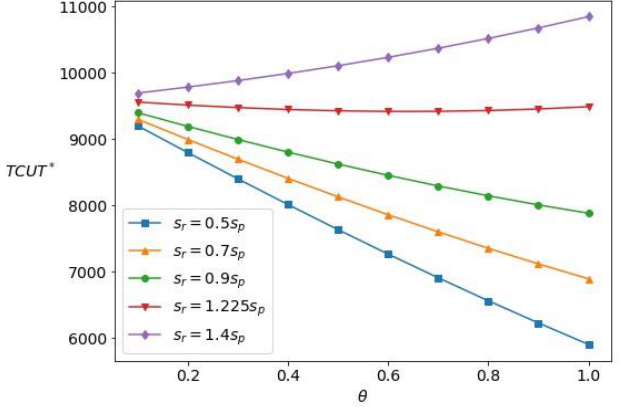
Fig. 3. Change of TCUT with respect to θ for various s r